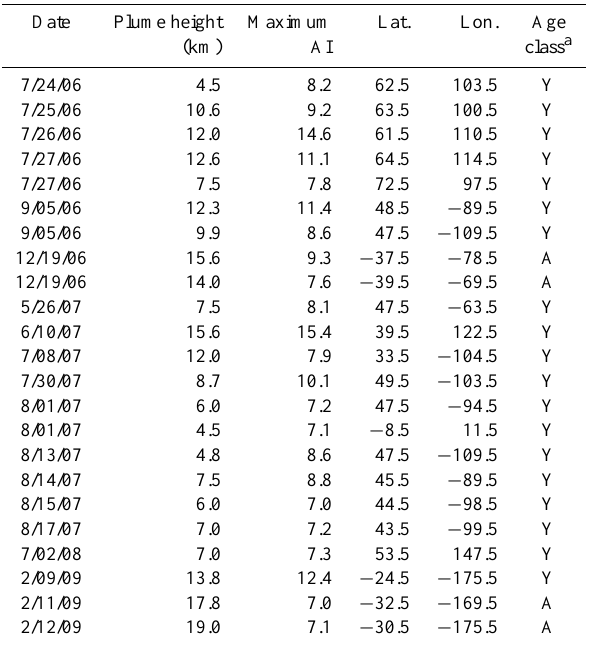
Table 1. The dates of large-AI biomass burning plumes with coin- cident CALIPSO